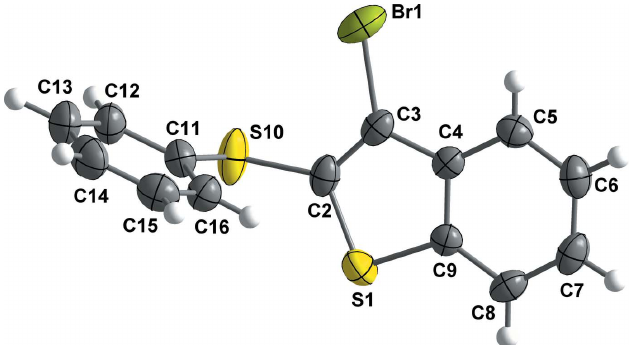
Figure 1 The molecular structure of 3-bromo-2-(phenylsulfanyl)benzo[ b ]thio- ]thiophene ( 1 ), with displacement ellipsoids drawn at the 50% probability level.